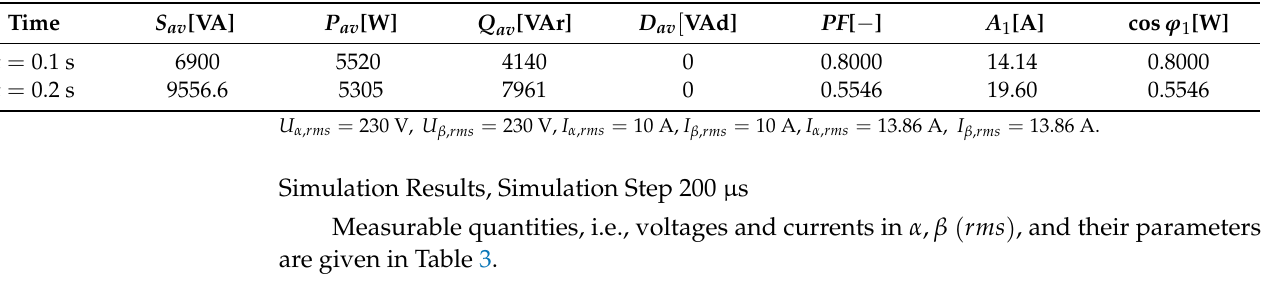
Table 2. Classical calculation before and after the change (at steady states).